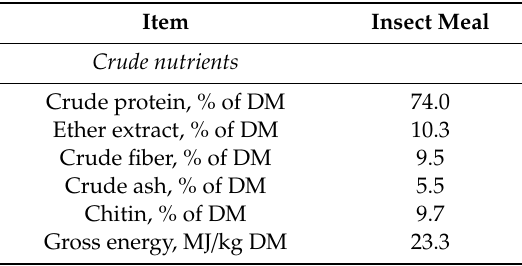
Table 2. Analyzed content of crude nutrients, amino acids, and fatty acids of the Tenebrio molitor larvae meal.